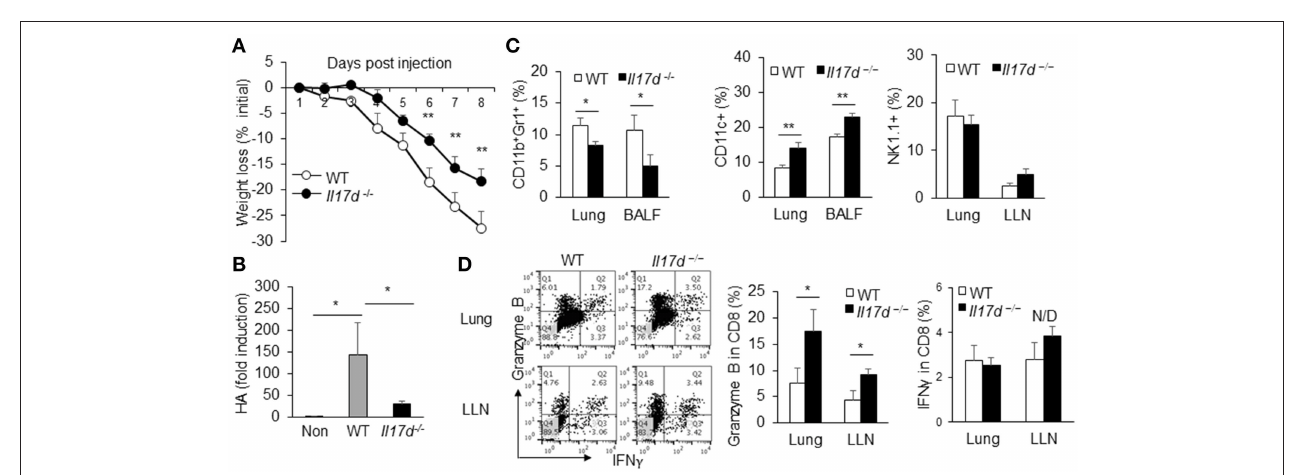
FIGURE 3 | IL-17D promotes pathogen burden of influenza A virus infection in mice. (A) WT ( n = 5) and Il17d − / − mice ( n = 4) were intranasal administrated with 13 PFUs of influenza A virus, and changes in body weight of WT and KO mice were monitored daily up to day 8. (B) Lung viral load was assessed via by qPCR of influenza A HA RNA. (C) BAL fluid cells and lung mononuclear cells were isolated and analyzed. CD11b + Gr1 + and CD11c cells from BAL fluid and lung mononuclear cells were stained by FACS. NK cells were examined in lung mononuclear cells and draining lymph nodes by FACS. (D) Production of granzyme B and IFN γ in CD8T cells in the lung and lung-draining lymph nodes by intracellular staining on day 9. The CD8T cells were re-stimulated with PMA and ionomycin for 5h before the staining. Data are representative of at least two or three independent experiments. * p ≤ 0.05, ** p ≤